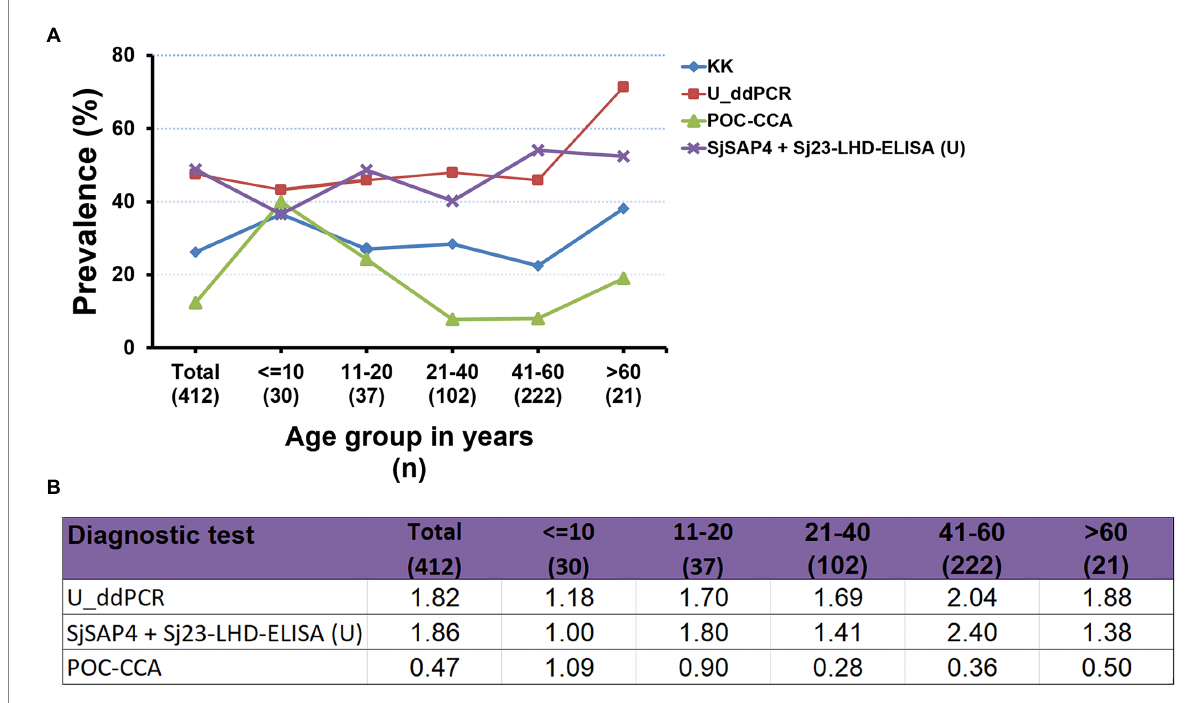
FIGURE 3 Comparison of the prevalence of S. japonicum infection determined by the different diagnostic tests. (A) The prevalence of schistosomiasis japonica determined by the KK procedure and three urine-based diagnostic tests [the U_ddPCR, SjSAP4 + Sj23-LHD-ELISA (U) and the POC-CCA assay] for the total human cohort by different age groups. (B) Fold changes in the prevalence of S. japonicum infection obtained with the U_ ddPCR, the urine ELISA and the POC-CCA assay vs. the KK examined for the total cohort by each age